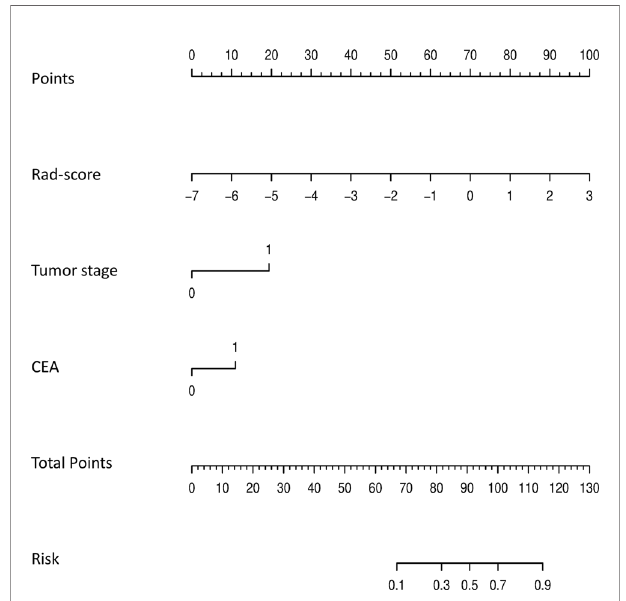
FIGURE 5 | The fi nal nomogram, including tumor stage, CEA, and rad-score, was used to predict PNI status. (PNI, perineural invasion; CEA, carcinoembryonic antigen).